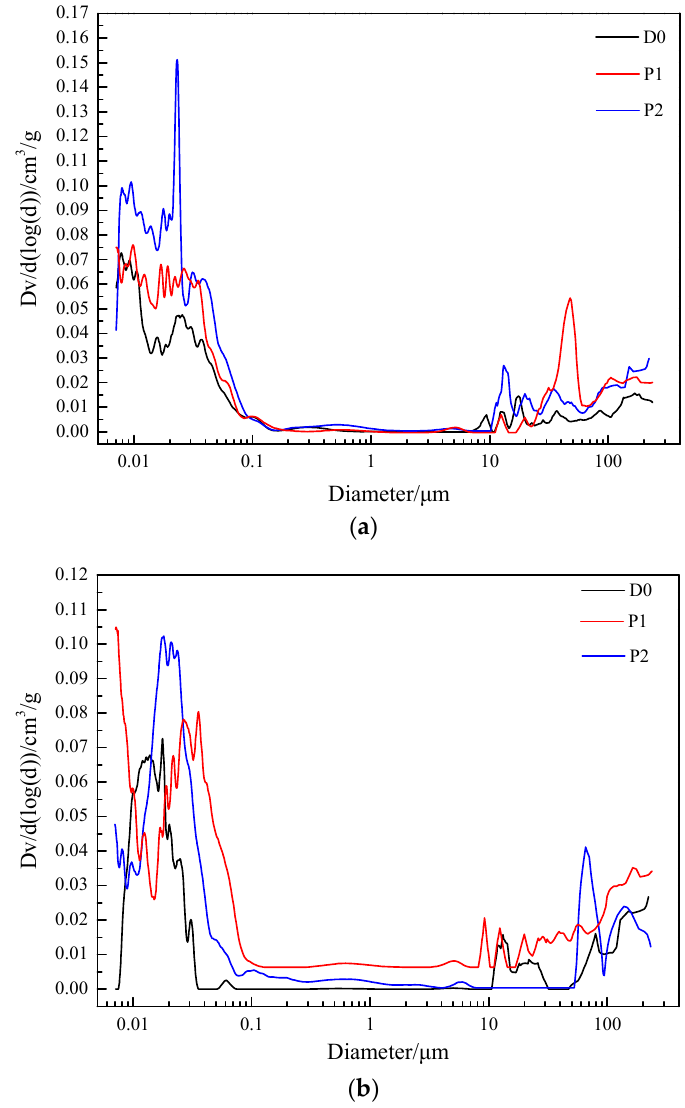
Figure 13. Pore distribution of composite cement by MIP. ( a ) Pore distribution of composite cement by MIP at 4 h; ( b ) pore distribution of composite cement by MIP at 28 days.